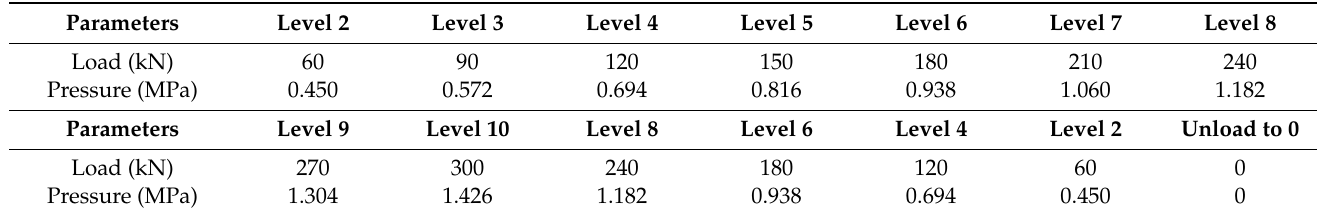
Table 5. Loading and unloading capacity at all levels and oil pressure of lifting jack in horizontal static load